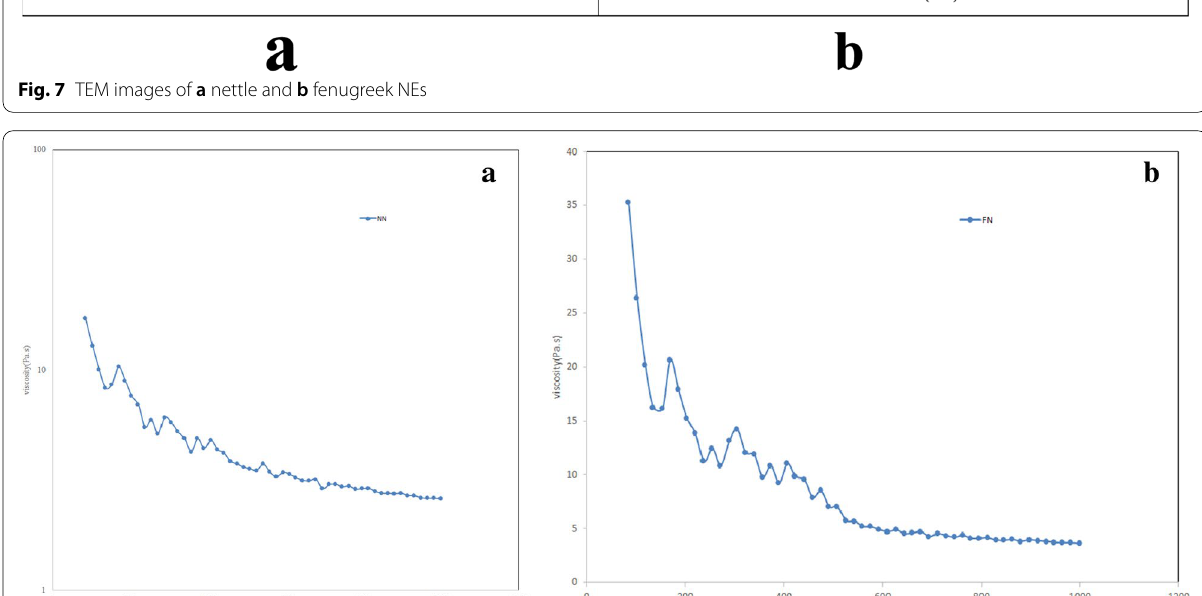
Fig. 7 TEM images of a nettle and b fenugreek NEs